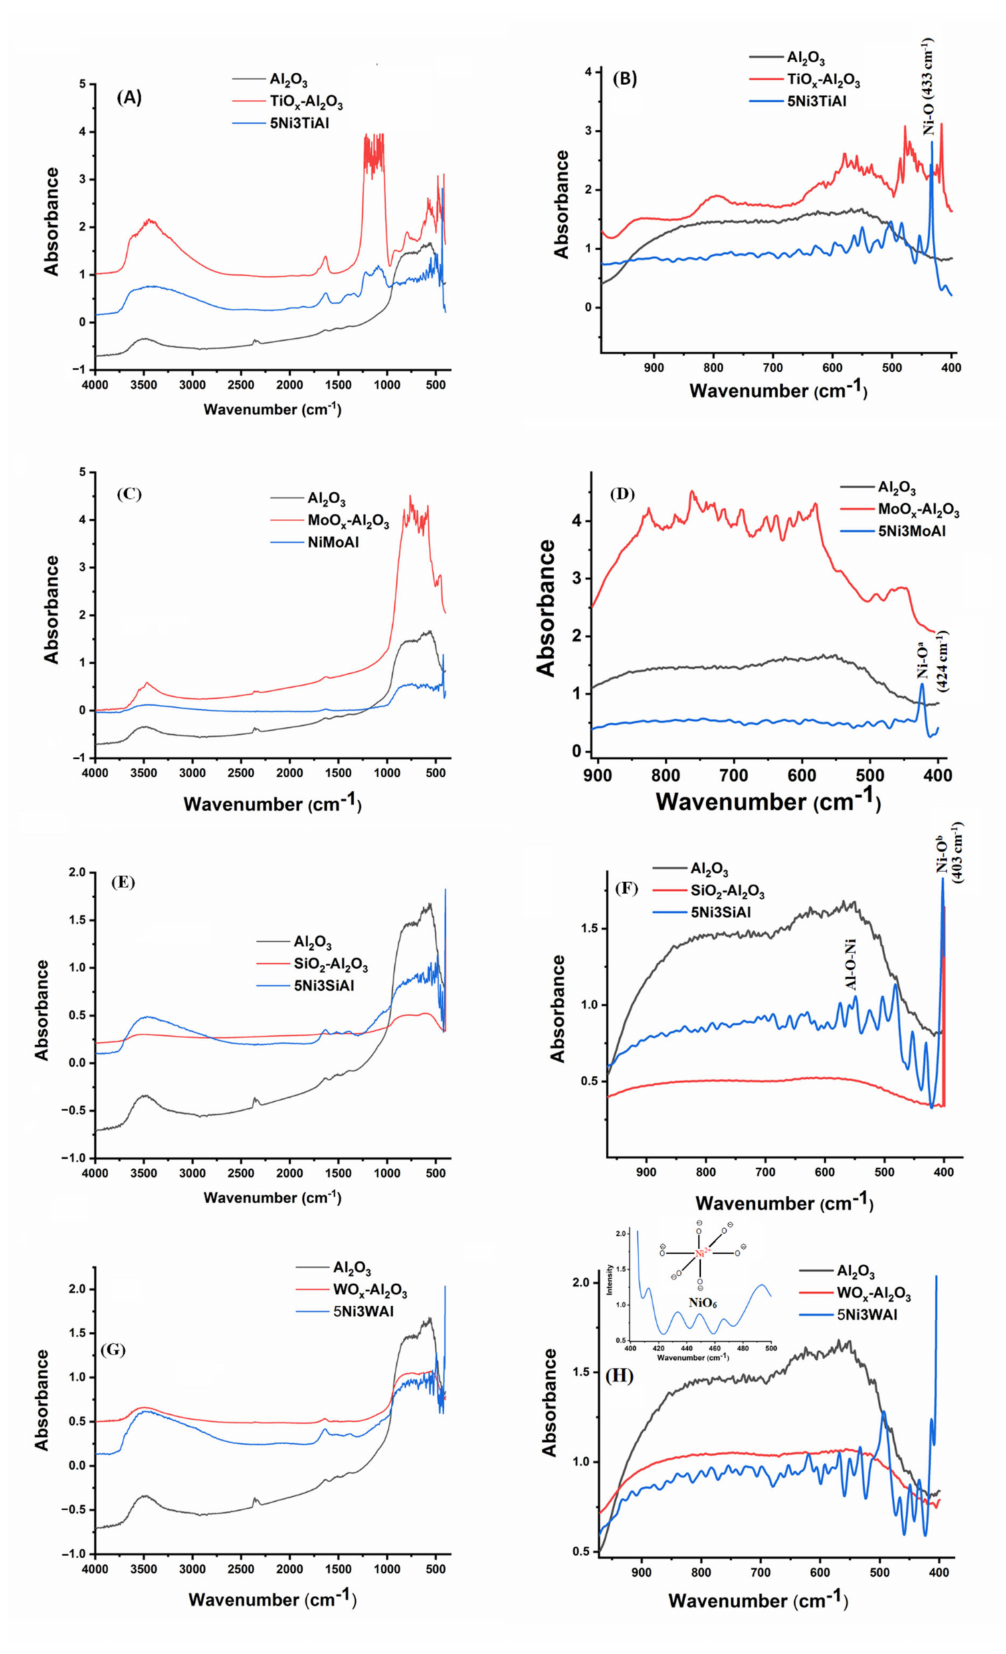
Figure 3. ( A – H ) Infrared spectra of different catalyst systems. In ( D ), Ni-O a indicates NiO species that interacted with the support. In ( F ) Ni-O b indicates NiO species that strongly interacted with the support. In ( H ) inset indicates stretching vibration peaks of NiO 6 polyhedra in NiWO 4